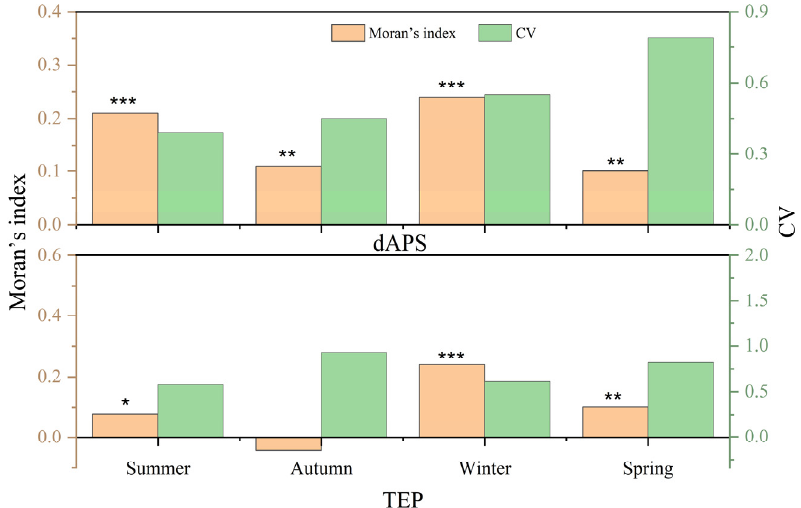
Figure 4. The Moran index and coefficient of variation for transparent exopolymer particles (TEP) and dissolved acidic polysaccharides (dAPS) in Taihu Lake. (Significance is annotated as * p ≤ 0.1, ** p ≤ 0.05, and *** p ≤ 0.01).